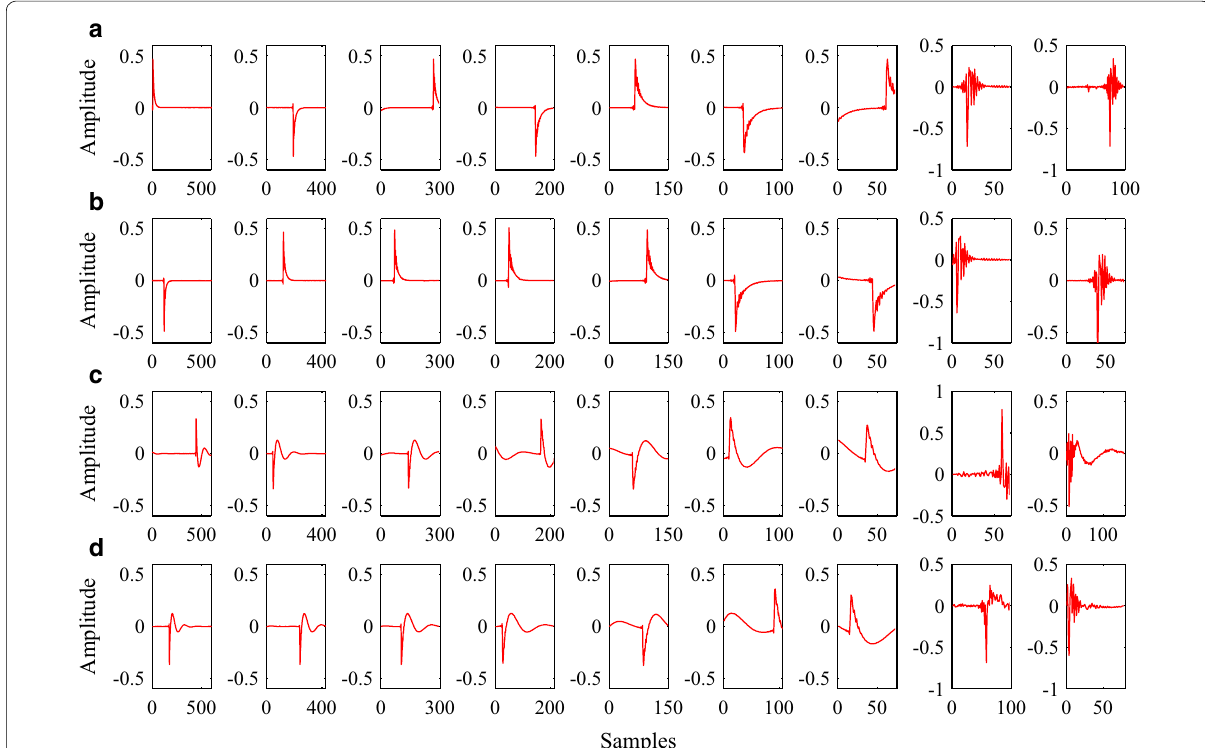
Fig. 4 Feature structures (atoms) learned from Ex ( a ), Ey ( b ), Hx ( c ) and Hy ( d ) components of the MT data set D 2 (a sampling rate of 150 Hz) using